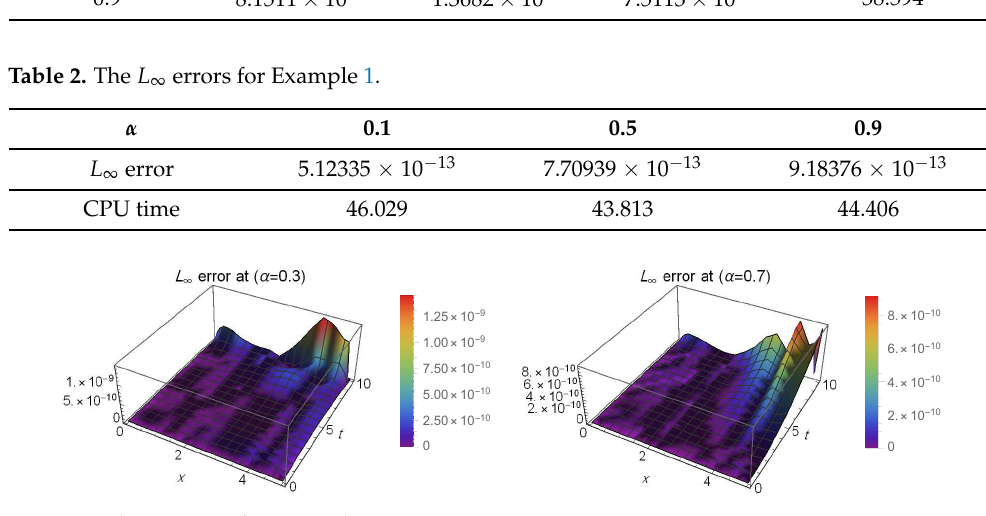
Figure 1. The L ∞ error for Example